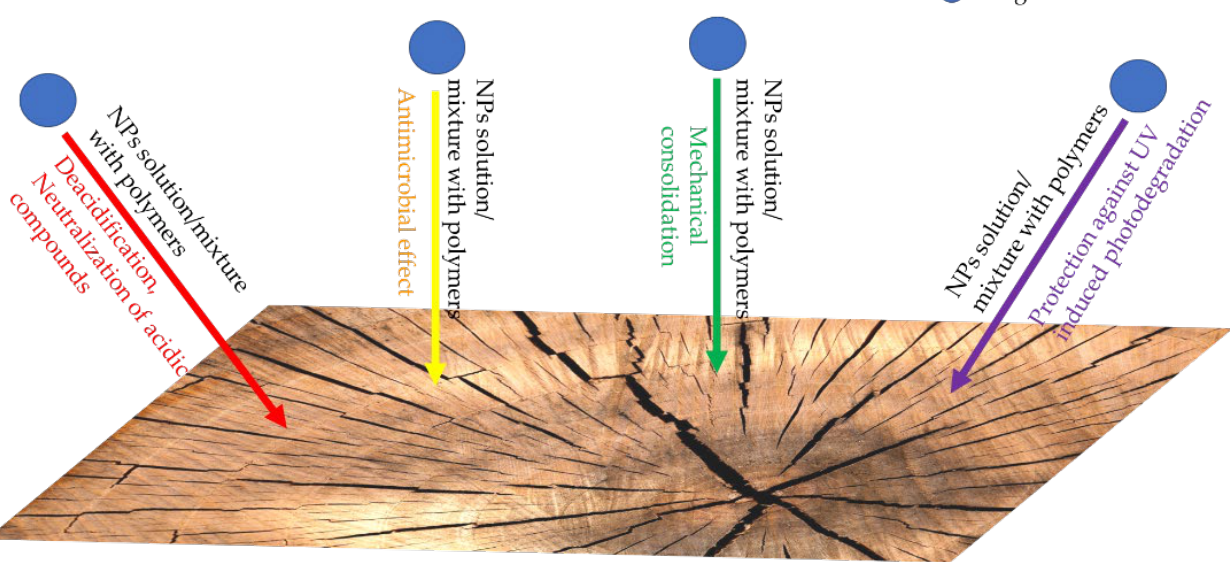
Figure 4. Potential application of nanomaterials for historical wood protection.